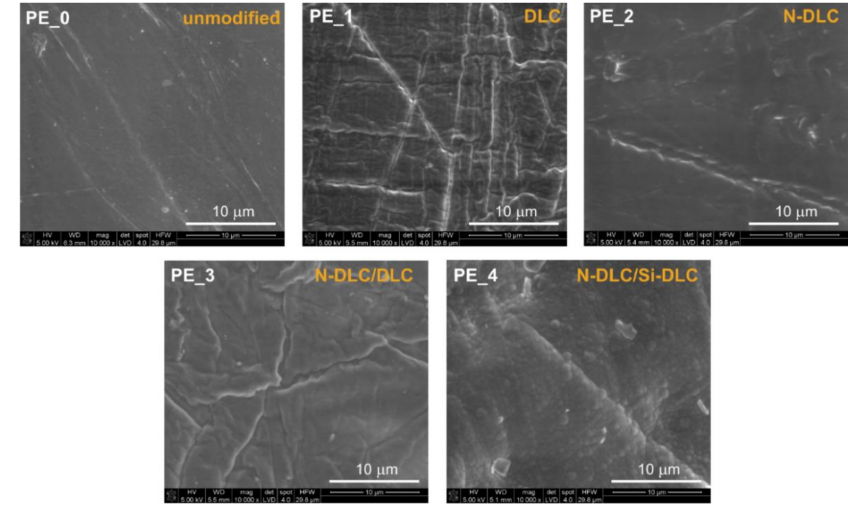
Figure 1. SEM images of unmodified polyethylene (PE) (PE_0 series) and selected modified PE surface after plasma processes: (PE_1) DLC deposition; (PE_2) N-DLC deposition; (PE_3) N-DLC and DLC deposition; (PE_4) N-DLC and Si-DLC